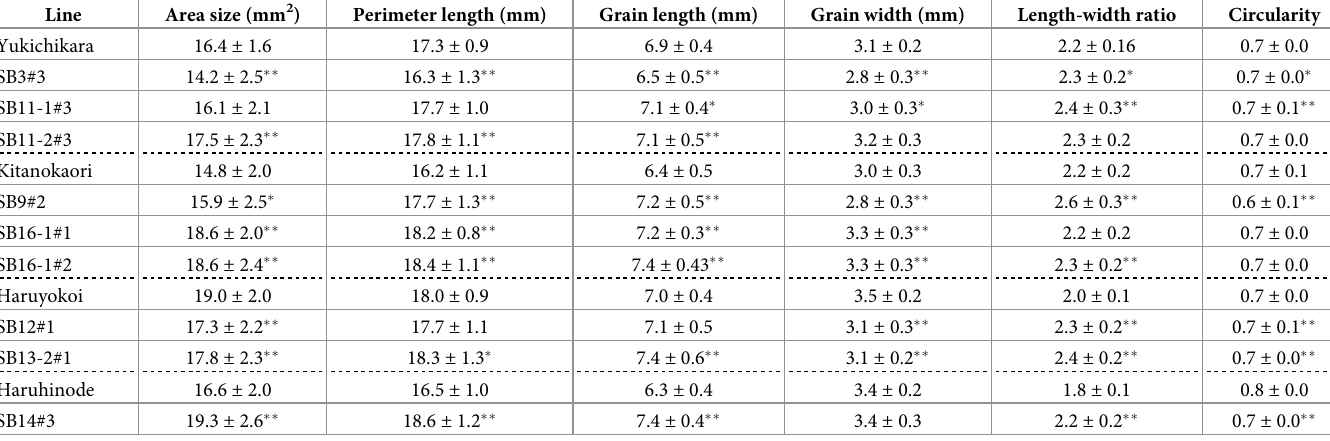
Table 2. Grain-related traits measured using SmartGrain software in the selected early flowering lines and their four parental cultivars. Line